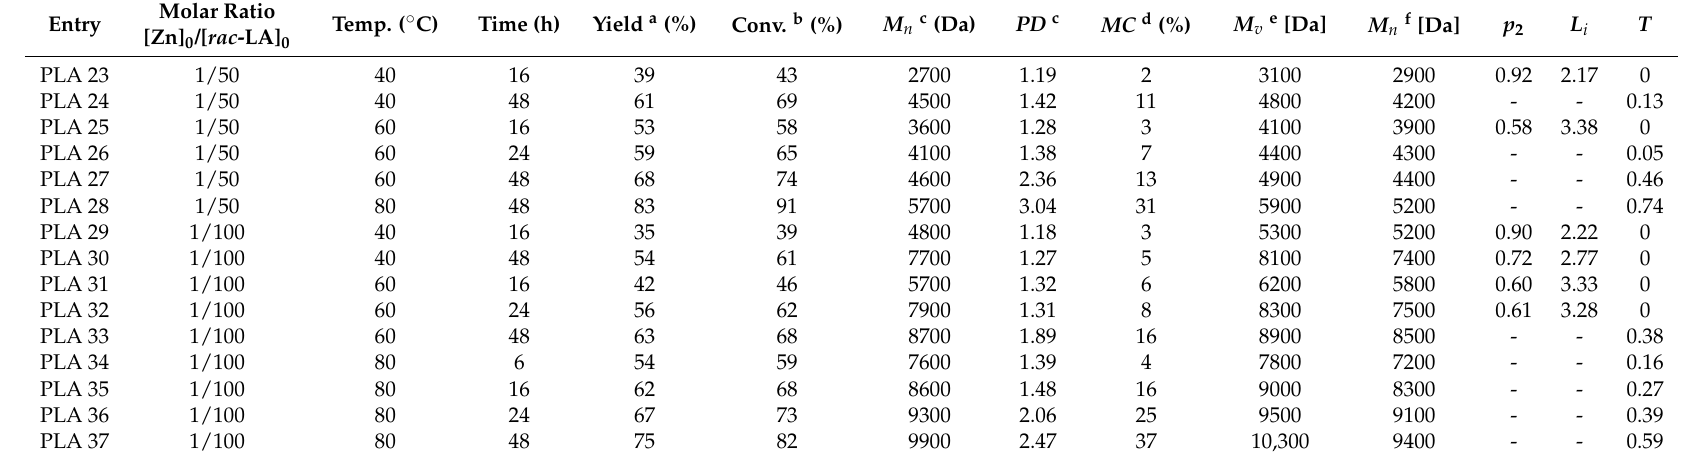
Table 3. Ring-opening polymerization of rac -LA in toluene in the presence of ZnEt 2 /PGAc catalytic system.